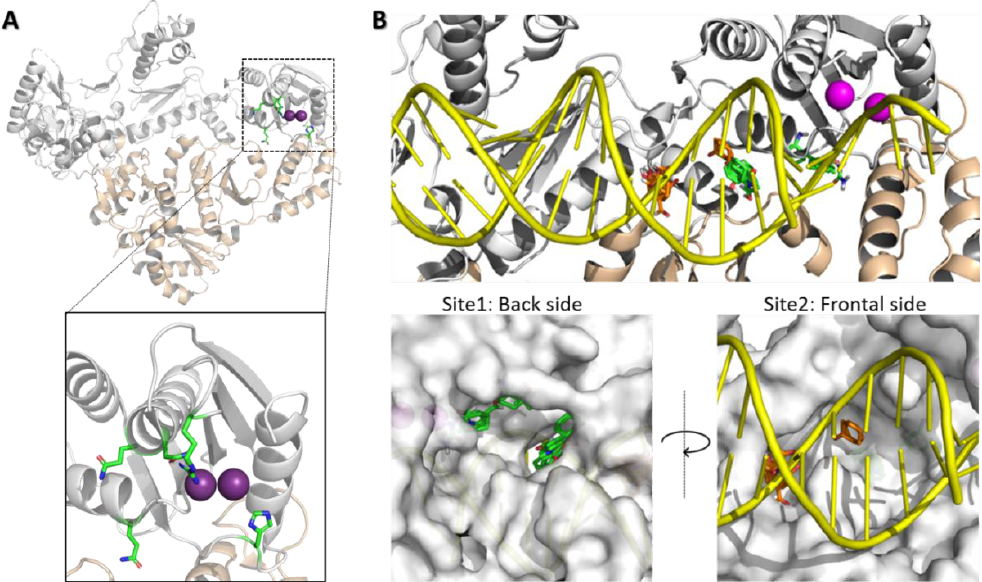
Figure 2. ( A ) Catalytic center of the RNase H domain. Residues involved in the protein-duplex stabilization and surrounding the catalytic center are highlighted in stick. ( B ) Position of the FTMap identified pockets. Green sticks, Site1 probes; orange sticks, Site2 probes; magenta spheres, Mg 2+ ions; white cartoon, p66; wheat cartoon, p55; yellow cartoon, DNA:DNA duplex. The figure was obtained using the 3LP1 structure. The DNA duplex coordinates were retrivied from 5J2M crystal structure. Three Site1 conformations were selected as significantly populated regions (i.e., regions with a #Pprobes ≥ 20 and at least one aromatic probe) in the 3LP1, 4I7F and 5K14 crystal structures. In all